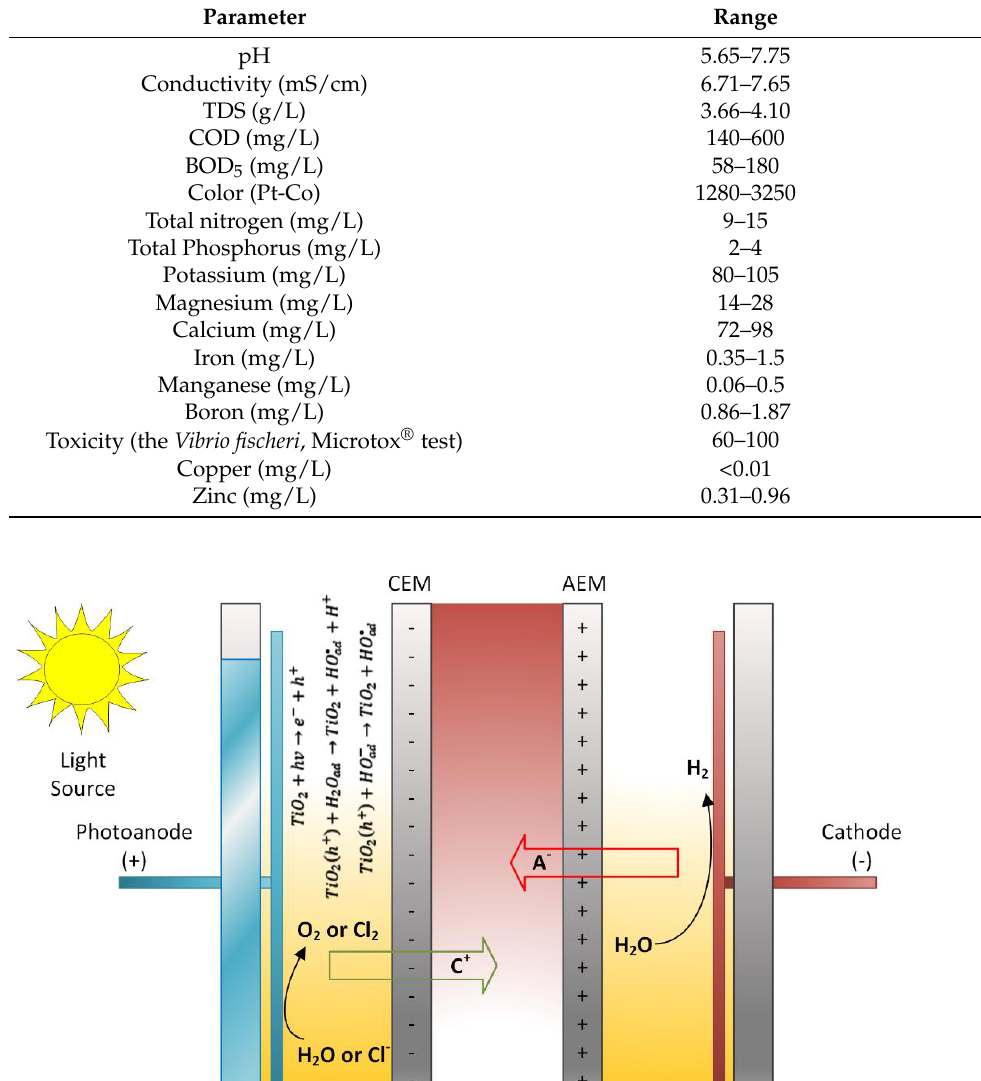
Table 1. Characterization of biologically treated textile wastewater.